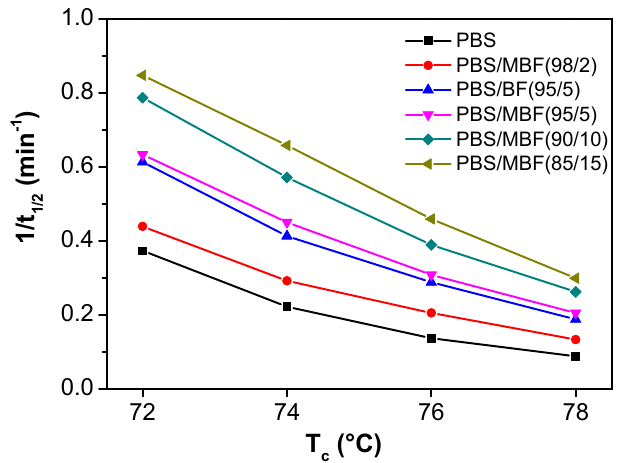
Figure 7. Variation of 1/ t 1/2 with T c for PBS, PBS/BF and PBS/MBF composites.